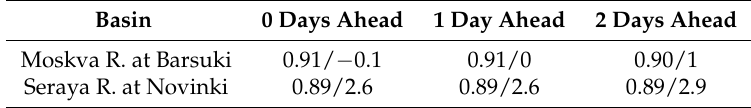
Table 5. Performance summary of updated runoff forecast using CAHEM observational data assimilation scheme for the period of OpenForecast operational evaluation. The numerator and denominator values stand for NSE and Bias,